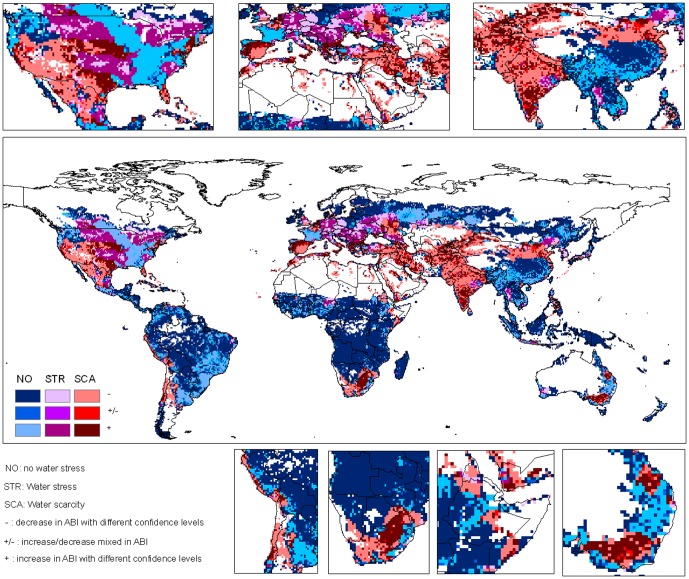
Change of irrigation water proportion in the 2030s in relation to water scarcity.Water scarcity is defined for the regions where total water withdrawal exceeds 40% of the freshwater resources, while water stress is defined for the regions where total water withdrawal is 20%–40% of the freshwater resources. ABI indicates irrigation water proportion.